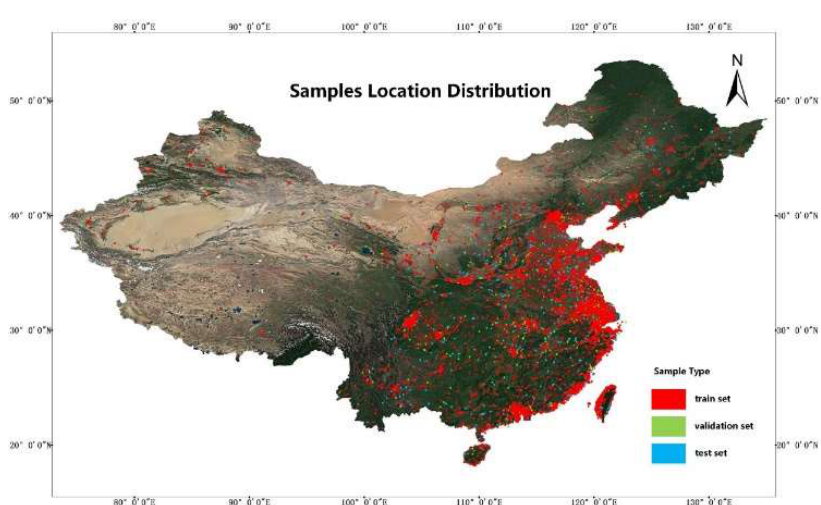
Figure 5. The distribution of our sample points. The red points, green points and blue points represents training samples (including 10,000 images), validation samples (including 2000 images) and test samples (including 44,000 images) respectively.